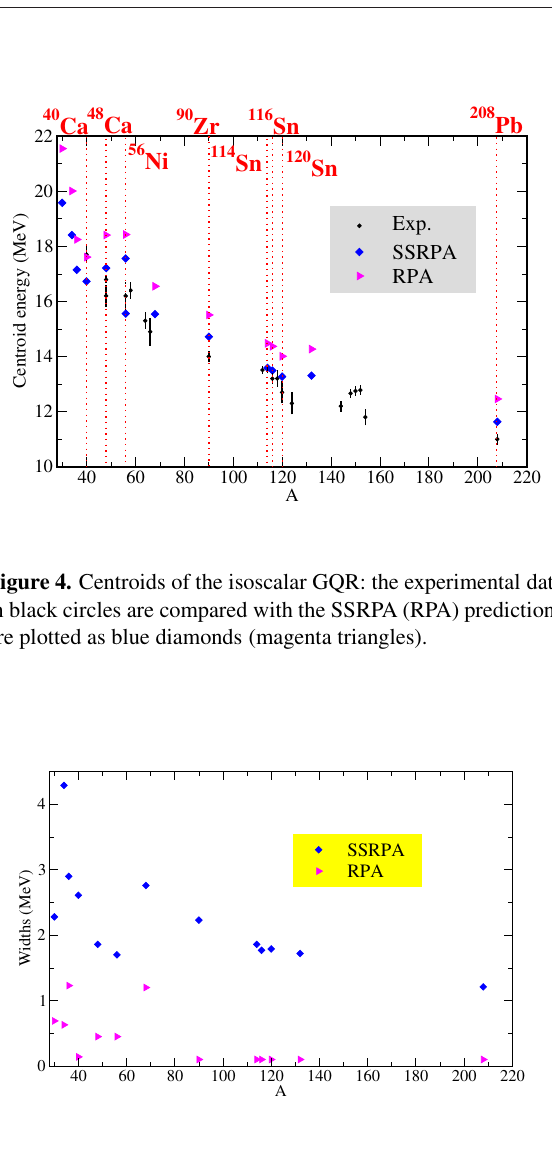
Figure 5. Theoretical widths calculated with the fit of a Lorentzian distribution within RPA and SSRPA